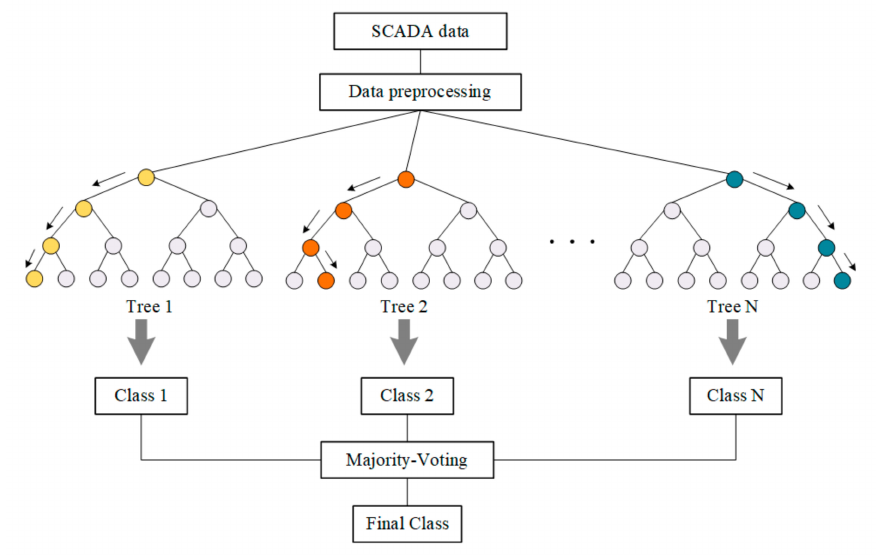
Figure 1. Flow chart of random